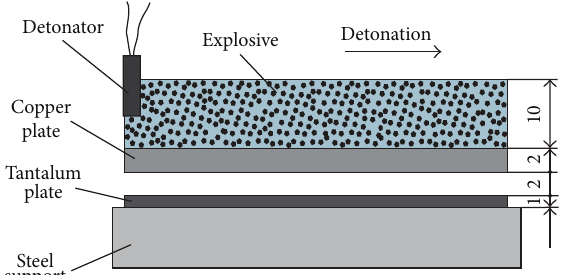
Figure 1: Schematic diagram of explosive welding with parallel arrangement of copper and tantalum plates.